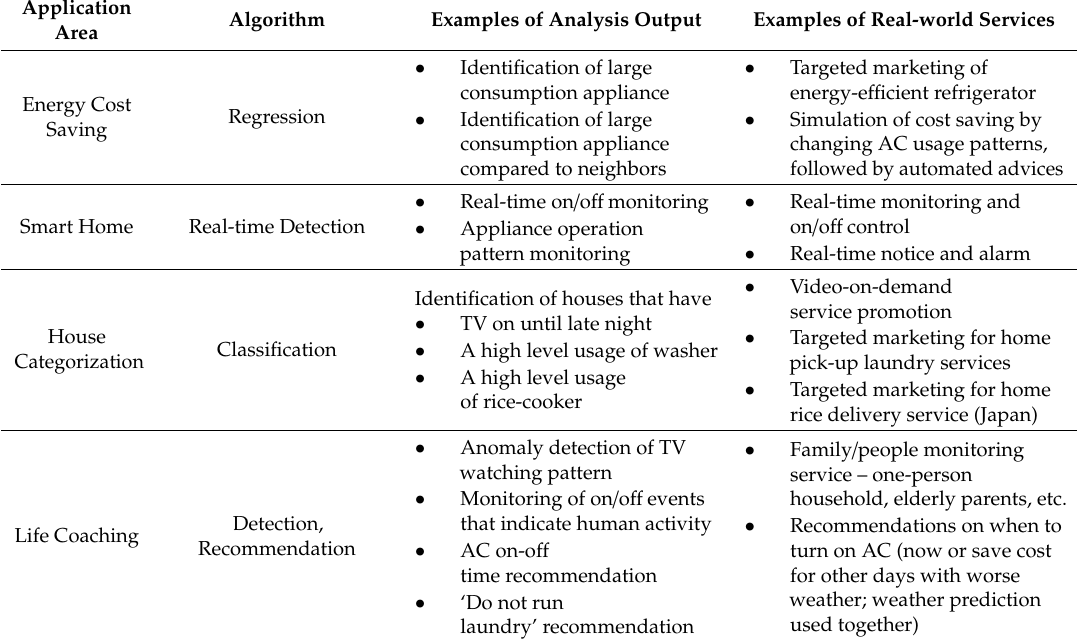
Table 1. Application areas of nonintrusive load monitoring (NILM).